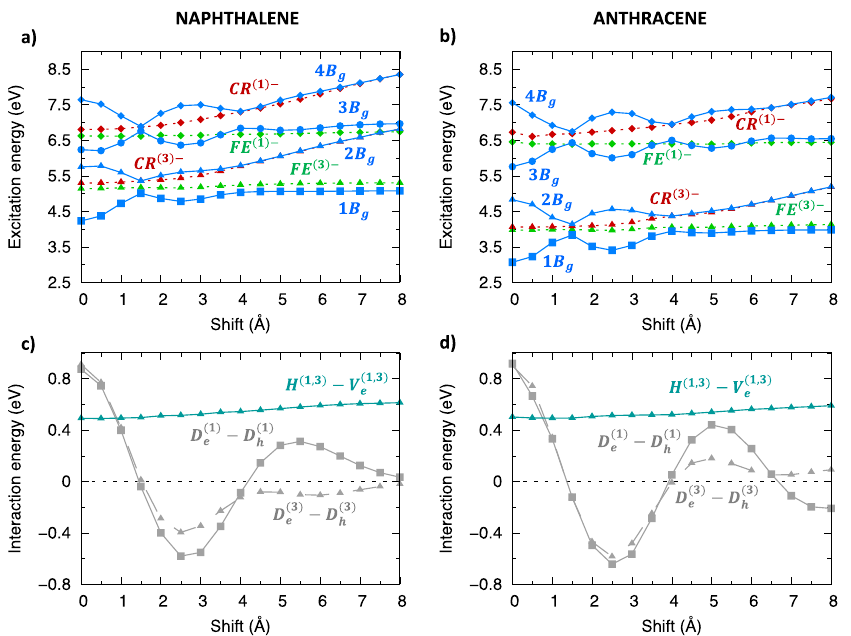
Figure 7. Analysis of the excitation energy profiles of singlet exciton states ( 𝐵 𝑔 symmetry) for (left) naphthalene and (right) anthracene dimer (TDA- ωB97X -D/6-31G * ) in terms of SA diabatic states (green for 𝐹𝐸 states, red for 𝐶𝑅 states) and their interactions. (top) Computed adiabatic and SA diabatic excitation energy profiles. (bottom) Magnitude and modulation along the longitudinal translation coordinate of the (grey) 𝐷 𝑒(1) − 𝐷 ℎ(1) , 𝐷 𝑒(3) − 𝐷 ℎ(3) interactions, coupling 𝐹𝐸 and 𝐶𝑅 states, and of the (dark-turquoise) 𝐻 (1,3) − 𝑉 𝑒(1,3) interactions mixing 𝐹𝐸 (1) and 𝐹𝐸 (3) states